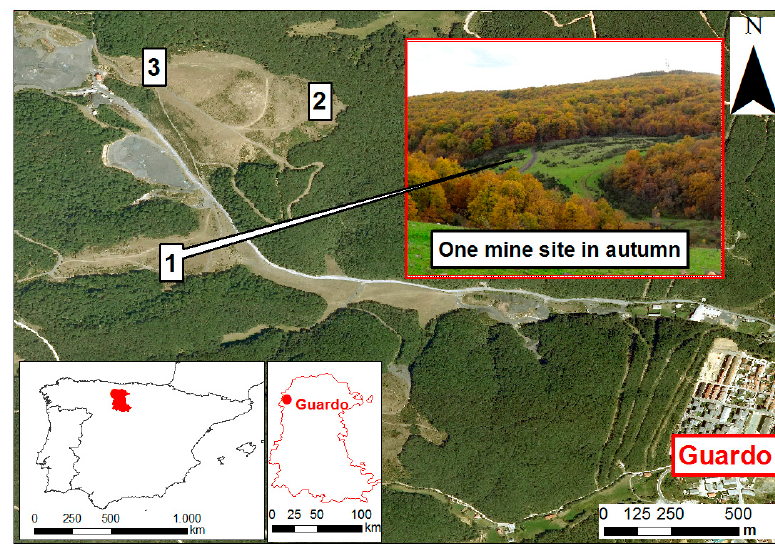
Figure A1. Location of the study sites in Northern Spain.